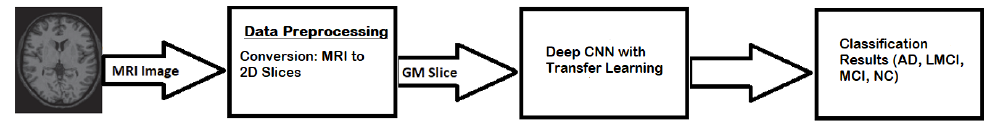
Figure 3. Proposed model